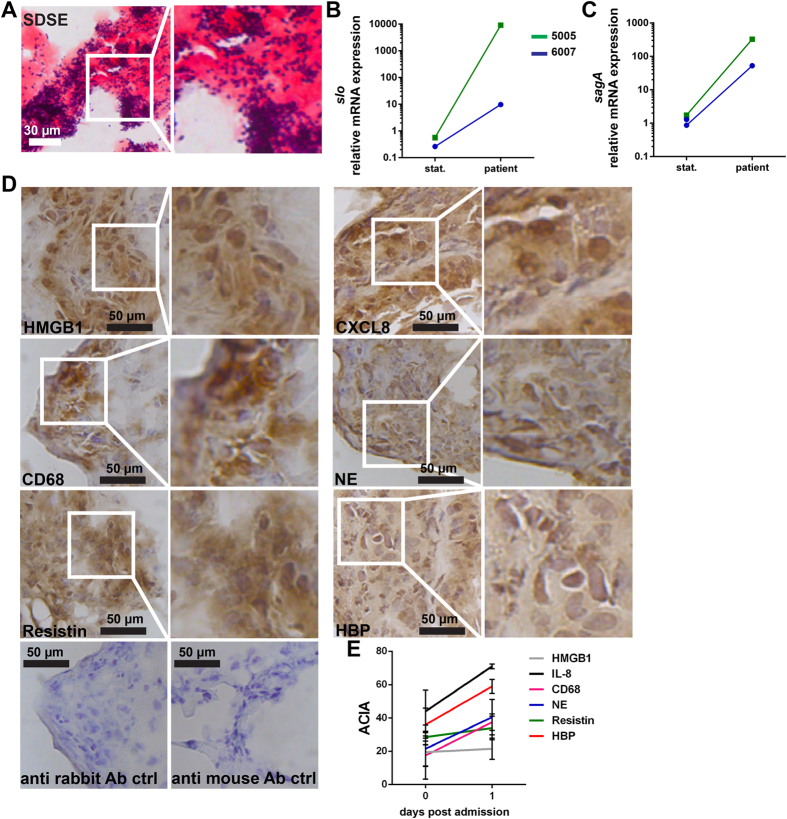
Infammation in patient biopsies as a result of high infiltration by bacteria and toxin production.(A) High bacterial load in patient biopsies visualized via Gram-staining. Relative mRNA expression of slo (B) and sagA (C) in patient biopsies. (D) Immunohistochemical detection of pro-inflammatory markers HMGB1 and CXCL,8 infiltrating immune cells (macrophages [CD68] and neutrophils [NE]), and activation markers Resistin and HBP in patient biopsies. (E) Image analysis values for all markers in patient biopsies at different days post admission. The sections were analyzed by acquired computerized image analysis (ACIA). Mean values ± SD from two biopsies of each patient are shown (dpa, days post admission).